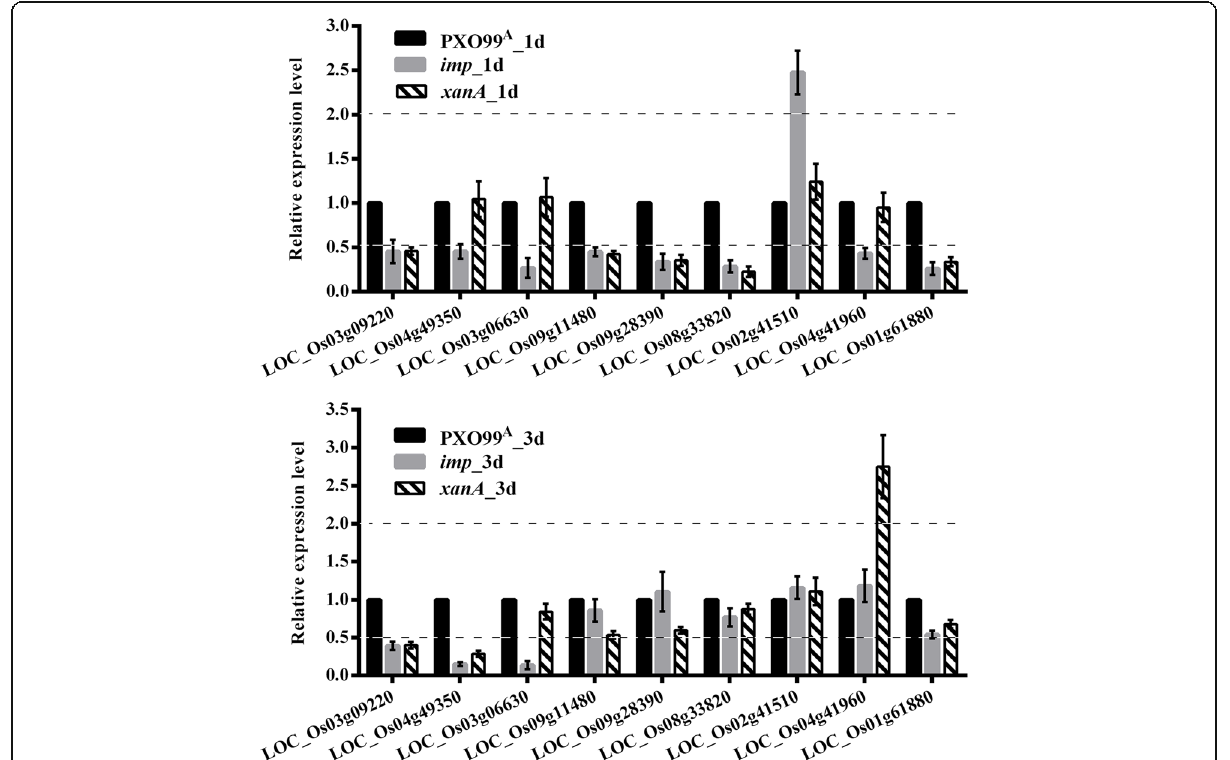
Fig. 8 The qRT-PCR validation of 9 randomly selected DEGs from RNA-Seq data. The genes eEF1a and actin were used as internal standard. PXO99 A _1d and PXO99 A _3d were as control groups at 1dpi and 3dpi respectively. Gene expression level in the control group was set to 1.0. The data were expressed as the mean fold change (means ± SD, n = 3) relative to the corresponding control group. The values were significantly different to the control when the relative expression level (fold change) ≥ 2 or ≤